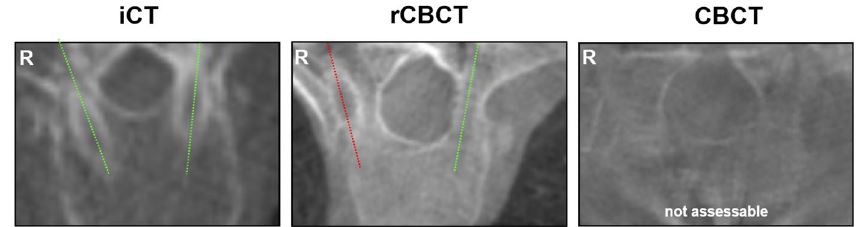
Figure 3. Examples of image quality and screw assessability using iCT, rCBCT and CBCT imaging in the thoracic spine. The green lines illustrate correctly placed screws (modified Rampersaud A + B) and the red line shows a misplaced screw (modified Rampersaud D). An example of non-assessable screw accuracy with CBCT imaging is shown in the right panel.